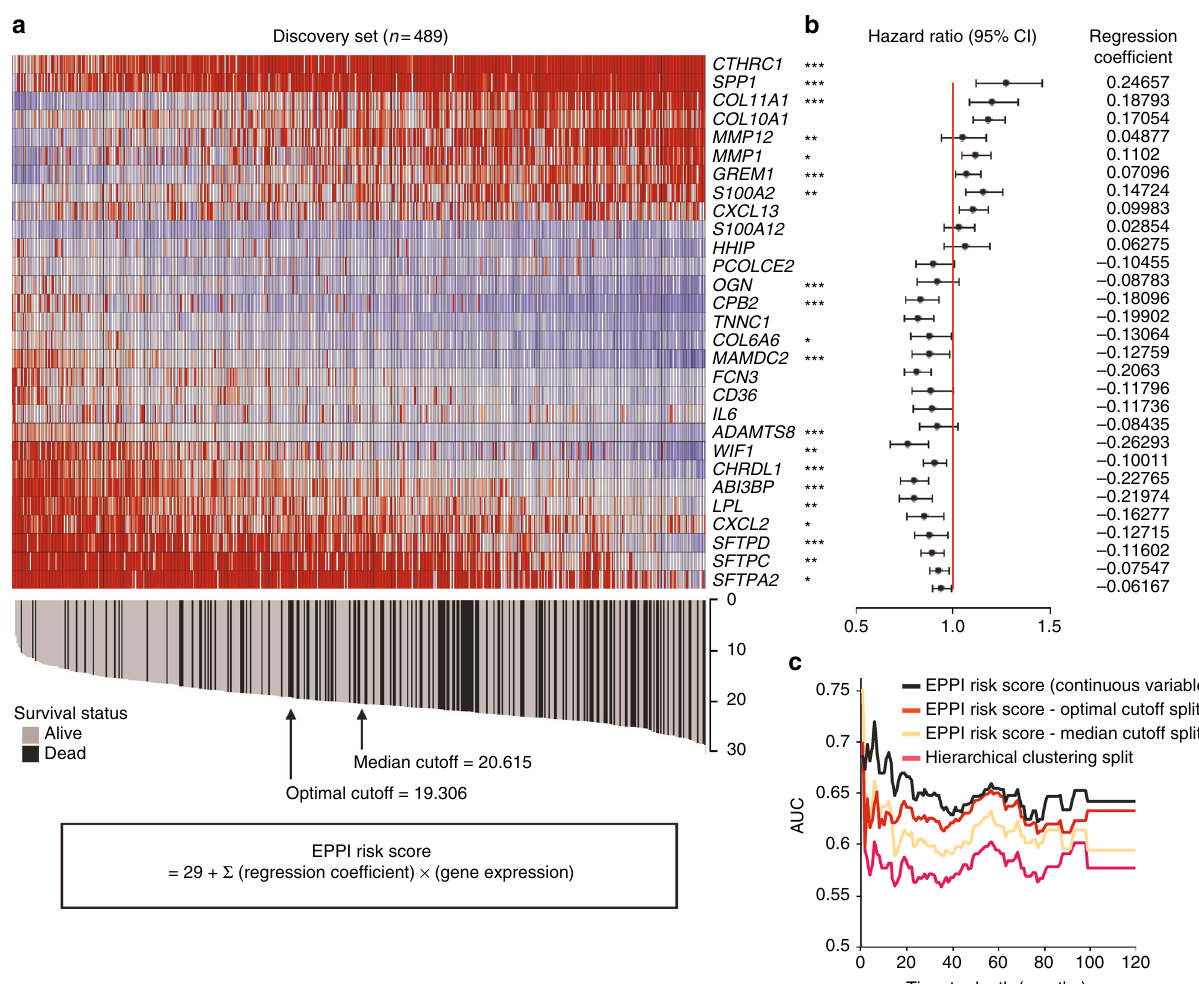
Fig. 3 Development of the EPPI risk scoring system. a Personalized EPPI gene expression heatmap in the discovery set comprising only early-stage patients (red = high expression, blue = low expression). Columns are ordered by increasing EPPI risk score. The score distribution, survival status of the patient and the median/optimal cutoff scores are illustrated below. b Forest plots of each EPPI gene expression in the discovery set. The horizontal axis represent hazard ratio (HR) with 95% con fi dence intervals (CI) estimated using a Cox proportional hazards model. The asterisks represent the statistical signi fi cance in patient survival outcome (*** P < 0.001, ** P < 0.01, * P < 0.05; log-rank P -value). c Time-dependent area under ROC curves (AUC) for different